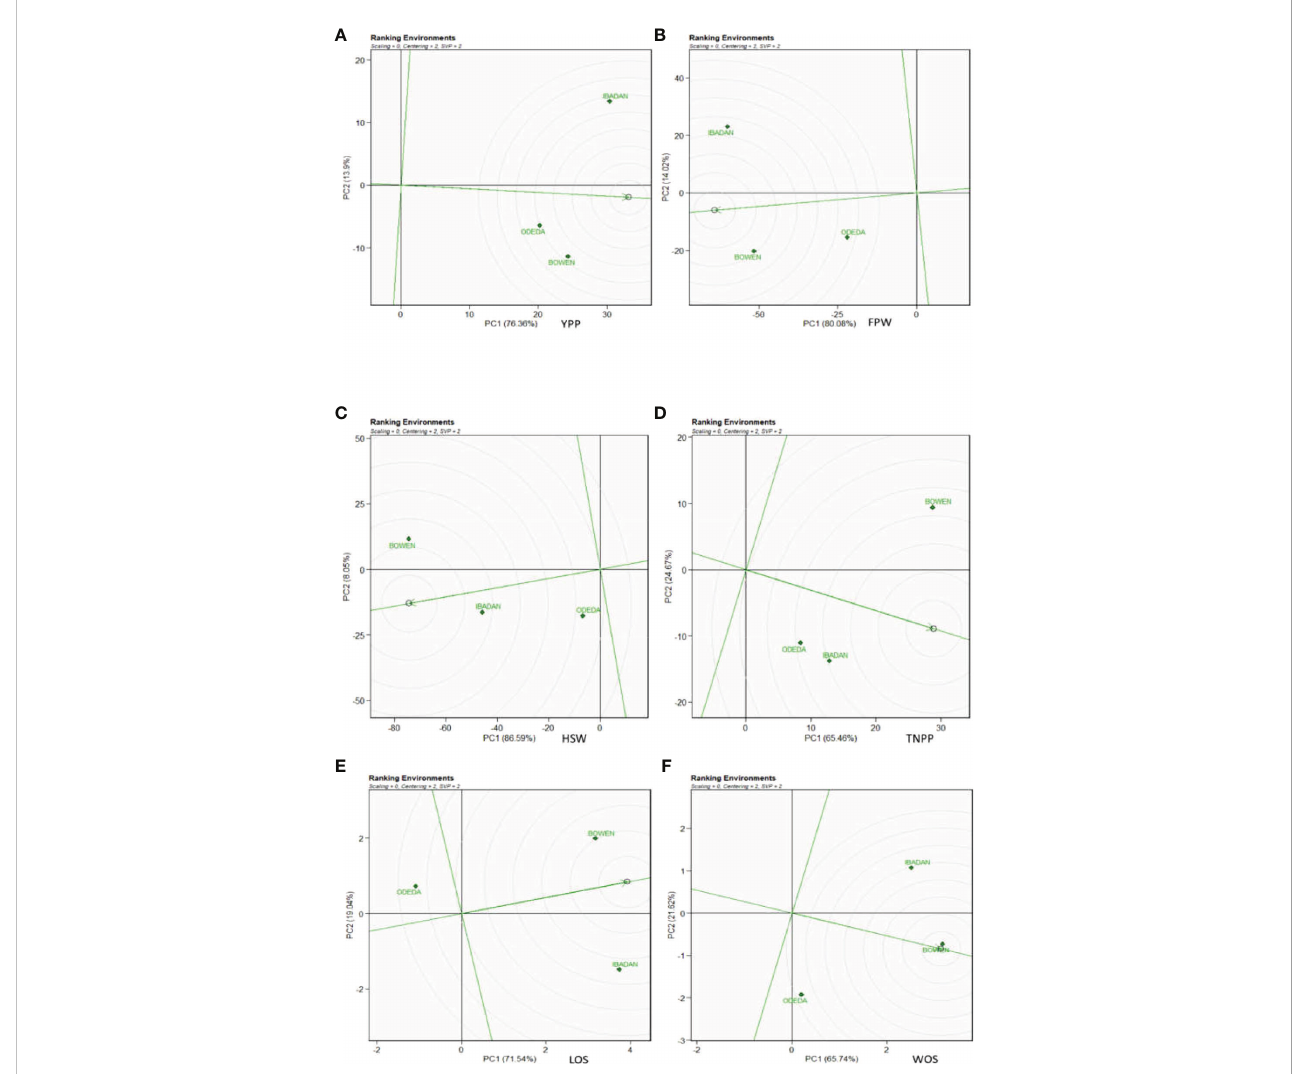
FIGURE 9 Ranking environments with the ideal environments for the growth of Bambara groundnut with respect to (A) yield per plant (YPP), (B) fresh pod weight (FPW), (C) total no. of pods per plant (TNPP), (D) hundred seed weight (HSW), (E) length of seeds (LOS), and (F) width of seeds (WOS). The GGE biplot polygons were based on scaling = 0, centering = 2, and singular value partitioning (SVP) =